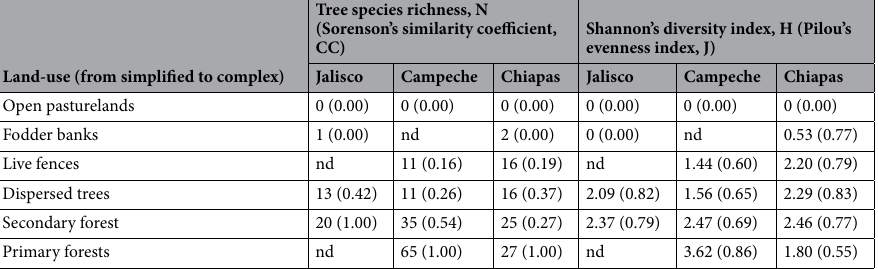
Table 1. Tree species richness, Sorenson´s similarity coefficients with primary forest species, Shannon´s diversity index, and Pilou´s evenness indices between land-uses for three study regions. PF Primary forests, SF Secondary forests, DT Dispersed tree in pasturelands, LF Live fences, FB Fodder banks, OP Open pasturelands. nd data not available.